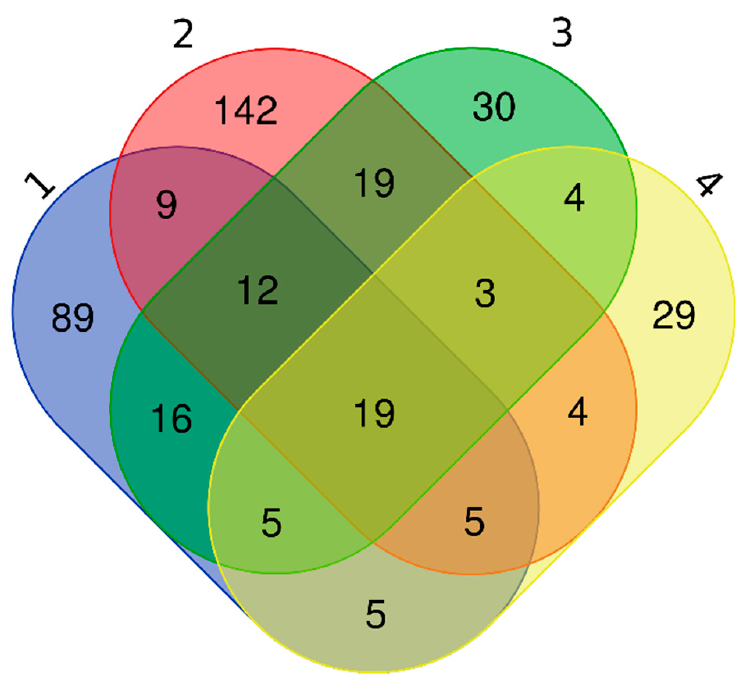
Figure 7. Comparison of proteins detected in our work in plasma-derived EVs from non-relapsed pediatric HL and in three works in plasma-derived EVs from healthy subjects (1: our work; 2: [58]; 3: [59]; 4: [60]). Venn diagram illustrates proteins shared by the four works and those unique of each